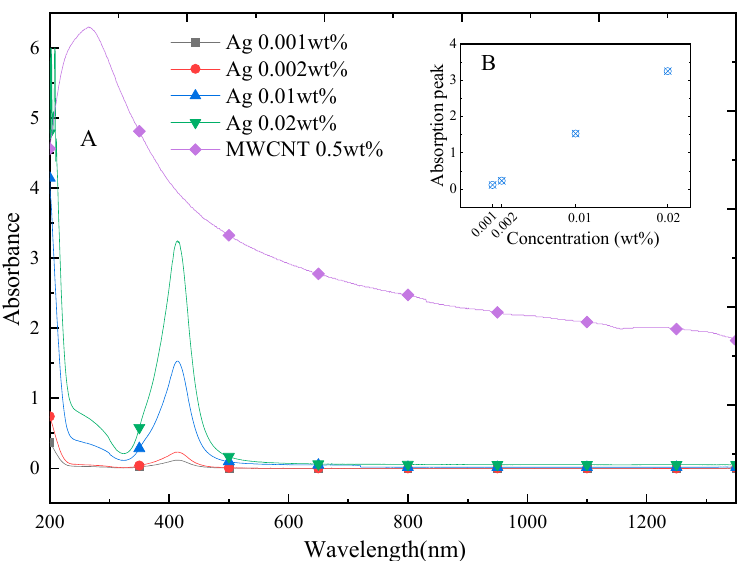
Figure 2. ( A ) Spectral-dependent absorbance of silver and MWCNT nanofluids under different volume fractions; ( B ) Absorption peak of silver nanofluids at different concentrations.